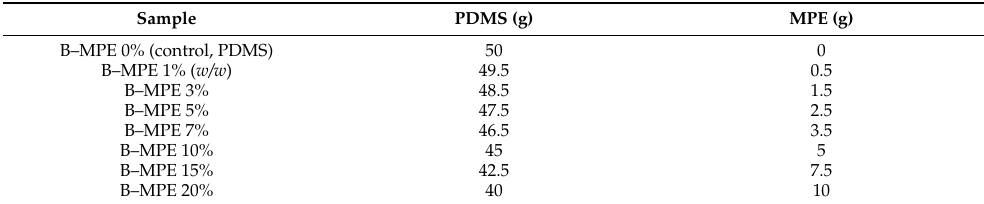
Table 1. Detailed manufacturing conditions of